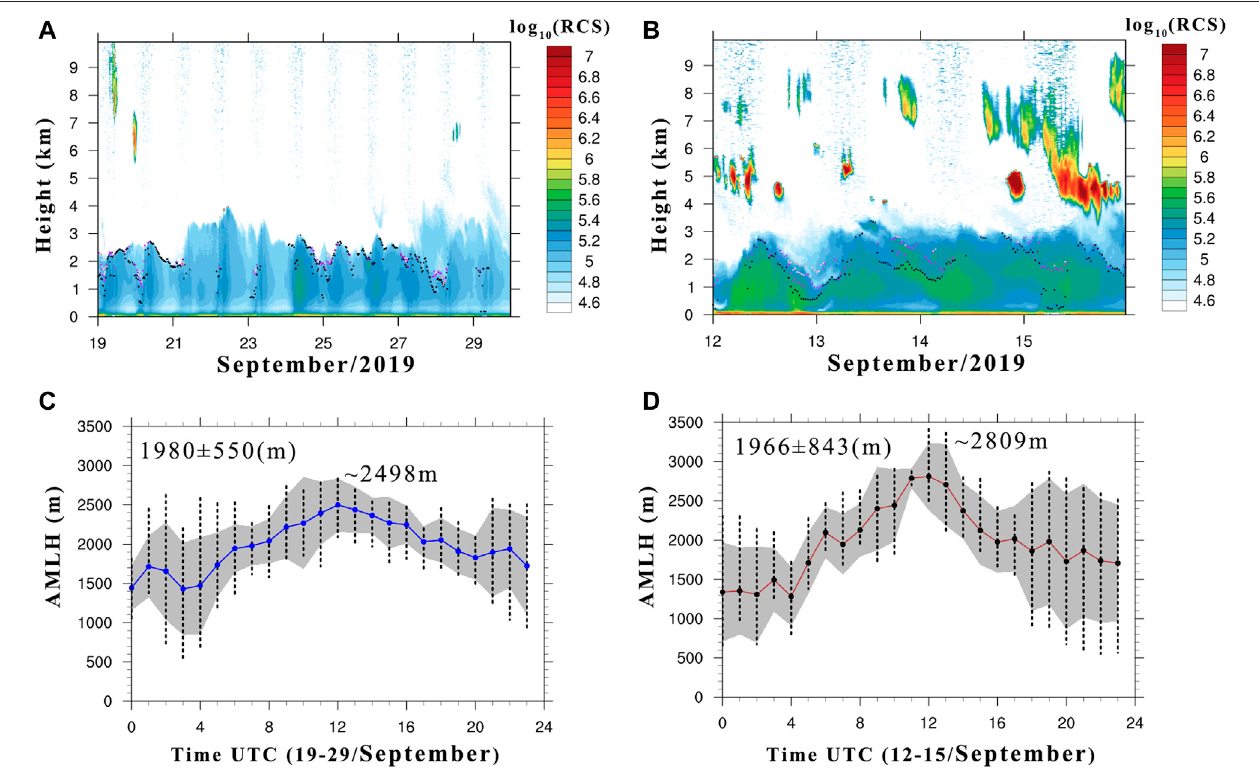
FIGURE 8 | Time evolutions of 30-min averaged log 10 (RCS) of the ceilometer at Tazhong. The black dots show the aerosol mixing layer height (AMLH). (A) Background levels of low aerosol concentrations under clear-sky conditions from September 19 to 30, 2019. (B) Vertical distributions of dust aerosols under fl oating dusty days from September 12 to 15, 2019. Hourly average diurnal variations of AMLH (in m) at Tazhong. The black dashed lines indicate the maximum or minimum values at the corresponding hour. The gray shades denote plus or minus one standard deviation. (C) Clear-sky days from September 19 to 30, 2019. (D) Floating dusty days from September 12 to 15, 2019. The overall means and maximum AMLH are shown in the fi gures.